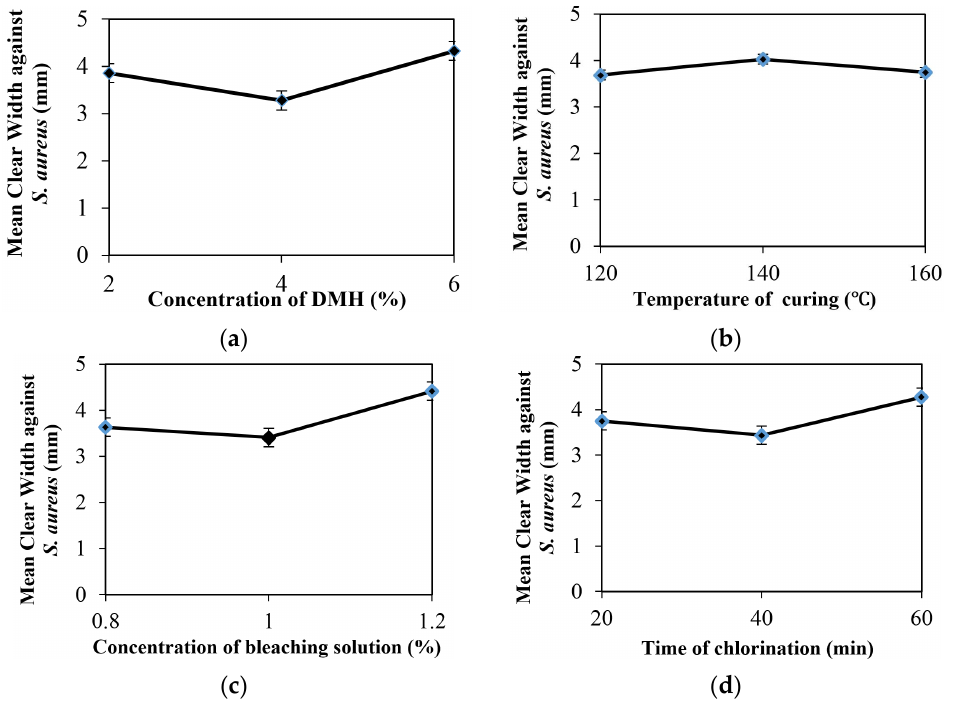
Figure 4. Effect of ( a ) concentration of DMH; ( b ) curing temperature; ( c ) concentration of the bleaching solution; and ( d ) time of chlorination on the antibacterial property of cotton fabric coated with DMH.